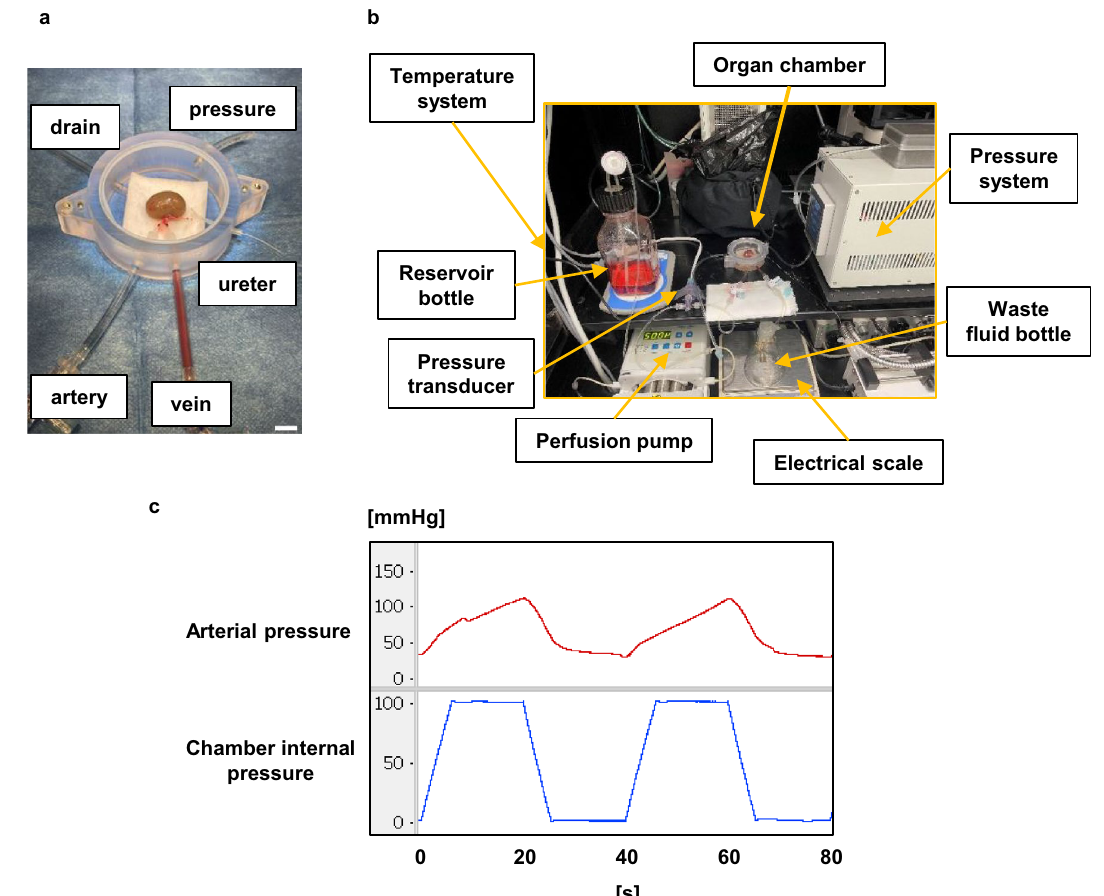
Figure 2. Normothermic machine perfusion system with an intermittent pressurization system for kidney perfusion culture. ( a ) The custom-made sealed chamber was used for perfusion of the left rat kidney. Five ports are provided to connect to the artery, vein, ureter, intermittent pressurization system, and waste fluid bottle. ( b ) The custom-made machine perfusion system. The system consisted of a perfusion pump, organ chamber, pressure system, temperature system, reservoir bottle, pressure transducer, waste fluid bottle, and electrical scale. The system set in the box maintained 37 °C. ( c ) Changes in chamber pressure and kidney arterial inlet pressure. A pressure of + 100 mmHg was applied intermittently for 20 s to the